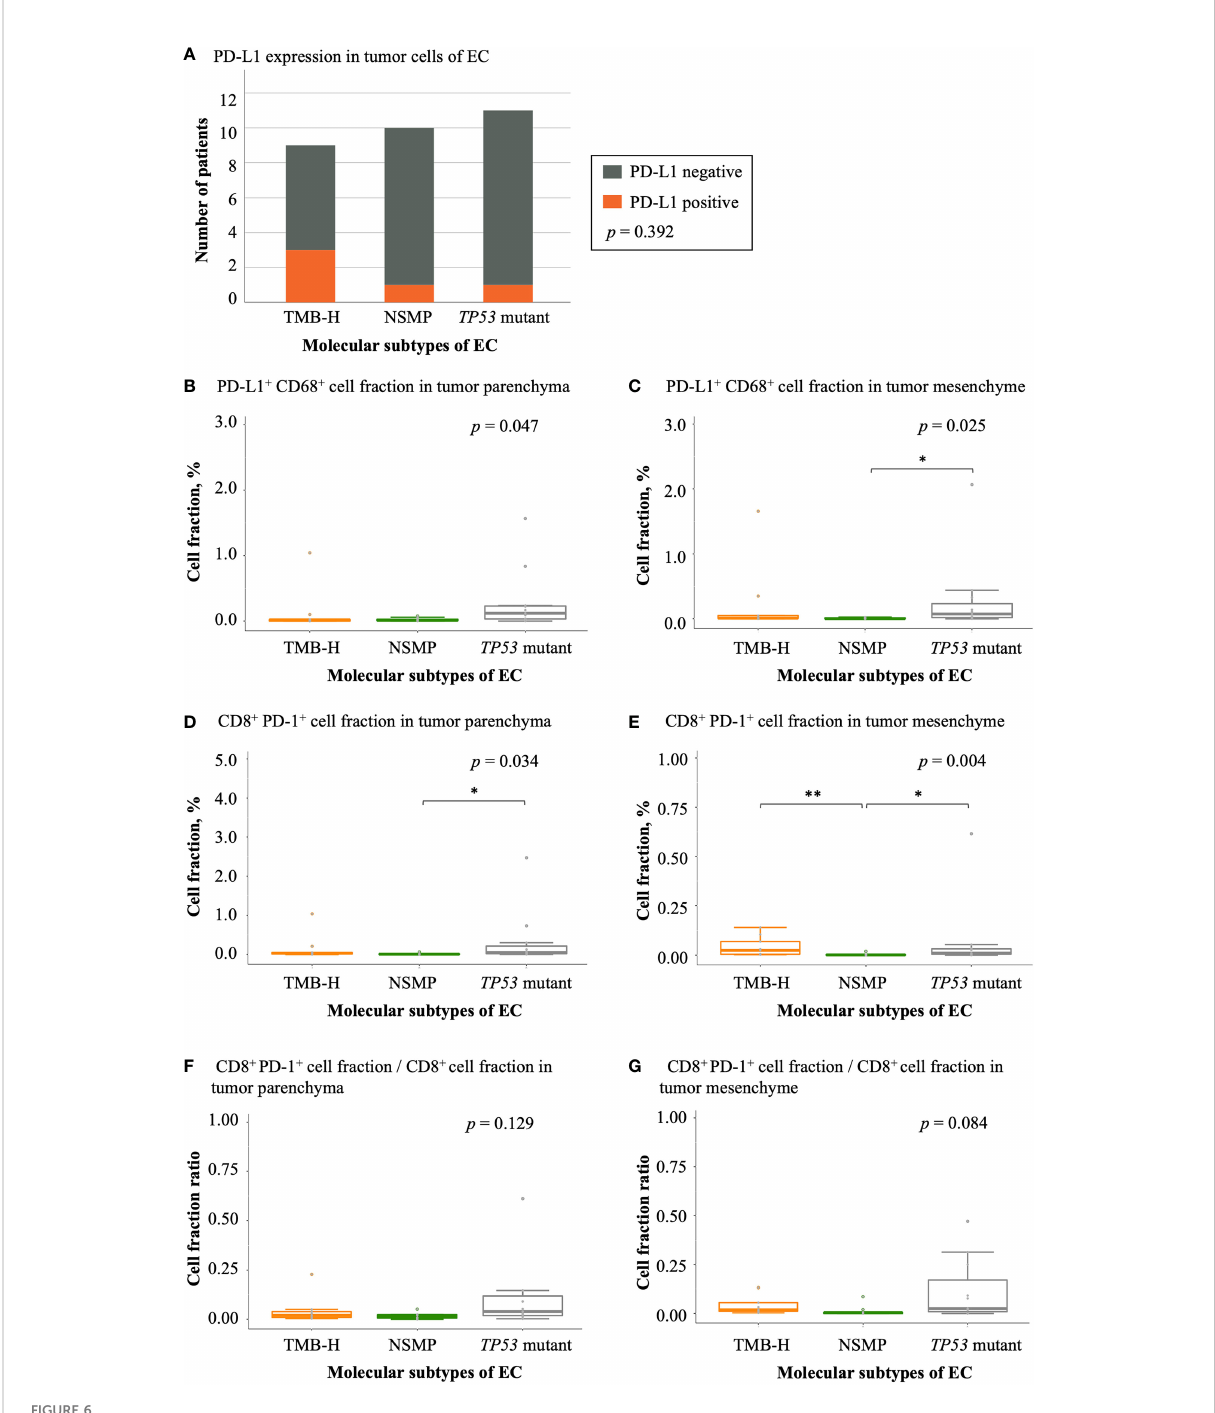
FIGURE 6 Expression of immune checkpoint molecules in EC. (A) PD-L1 expression in different EC molecular subtypes. The p value of Fisher ’ s exact test for overall comparison is given. (B, C) PD-L1 + CD68 + cell fractions in tumor parenchyma and mesenchyme. (D, E) CD8 + PD-1 + cell fractions in tumor parenchyma and mesenchyme. (F, G) The ratio of CD8 + PD-1 + cell fractions to CD8 + T cell fractions in tumor parenchyma and mesenchyme. For (B-G) , the p values of Kruskal-Wallis test for overall comparisons are given, and signi fi cant levels in pairwise comparisons are shown in the fi gure. In all panels, n = 9 for TMB-H, 10 for NSMP, 11 for TP53 mutant. The dots above the boxplots indicate outliers. TMB-H, high tumor mutation burden; NSMP, no speci fi c molecular pro fi le; EC, endometrial cancer. * p < 0.05, ** p <